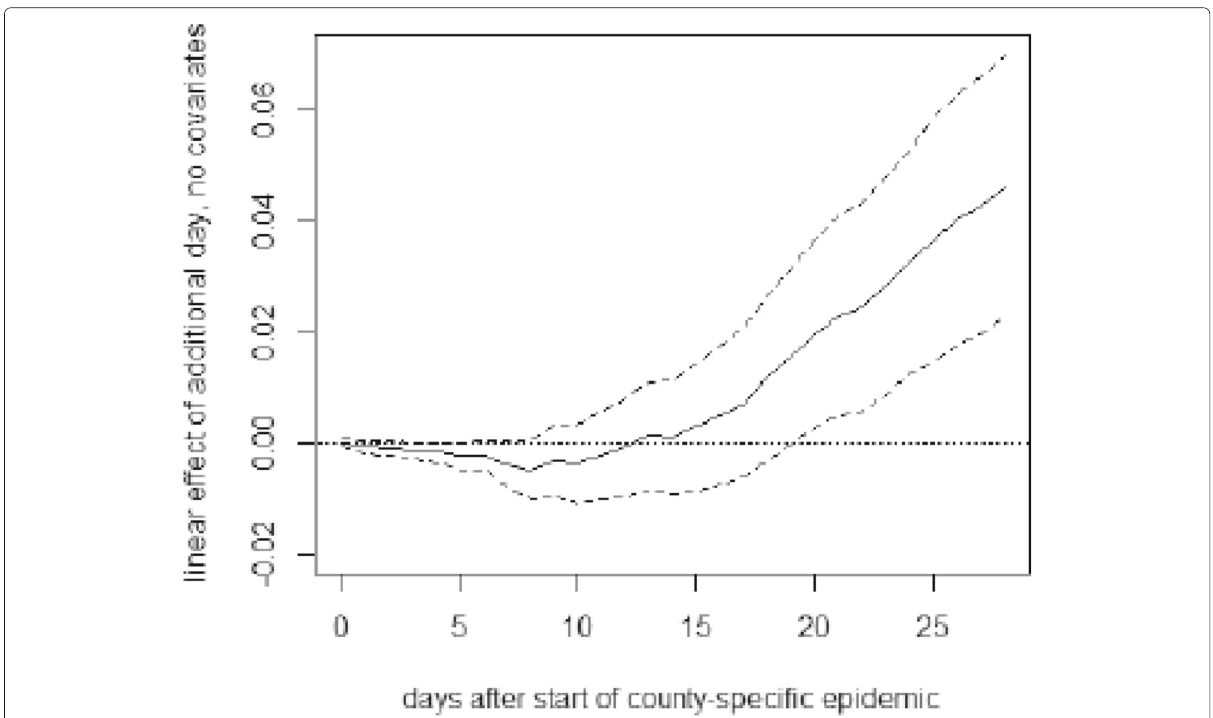
Fig. 12 OLS effect of delaying lockdown by 1 day on deaths per 10,000 inhabitants in Germany without covariates